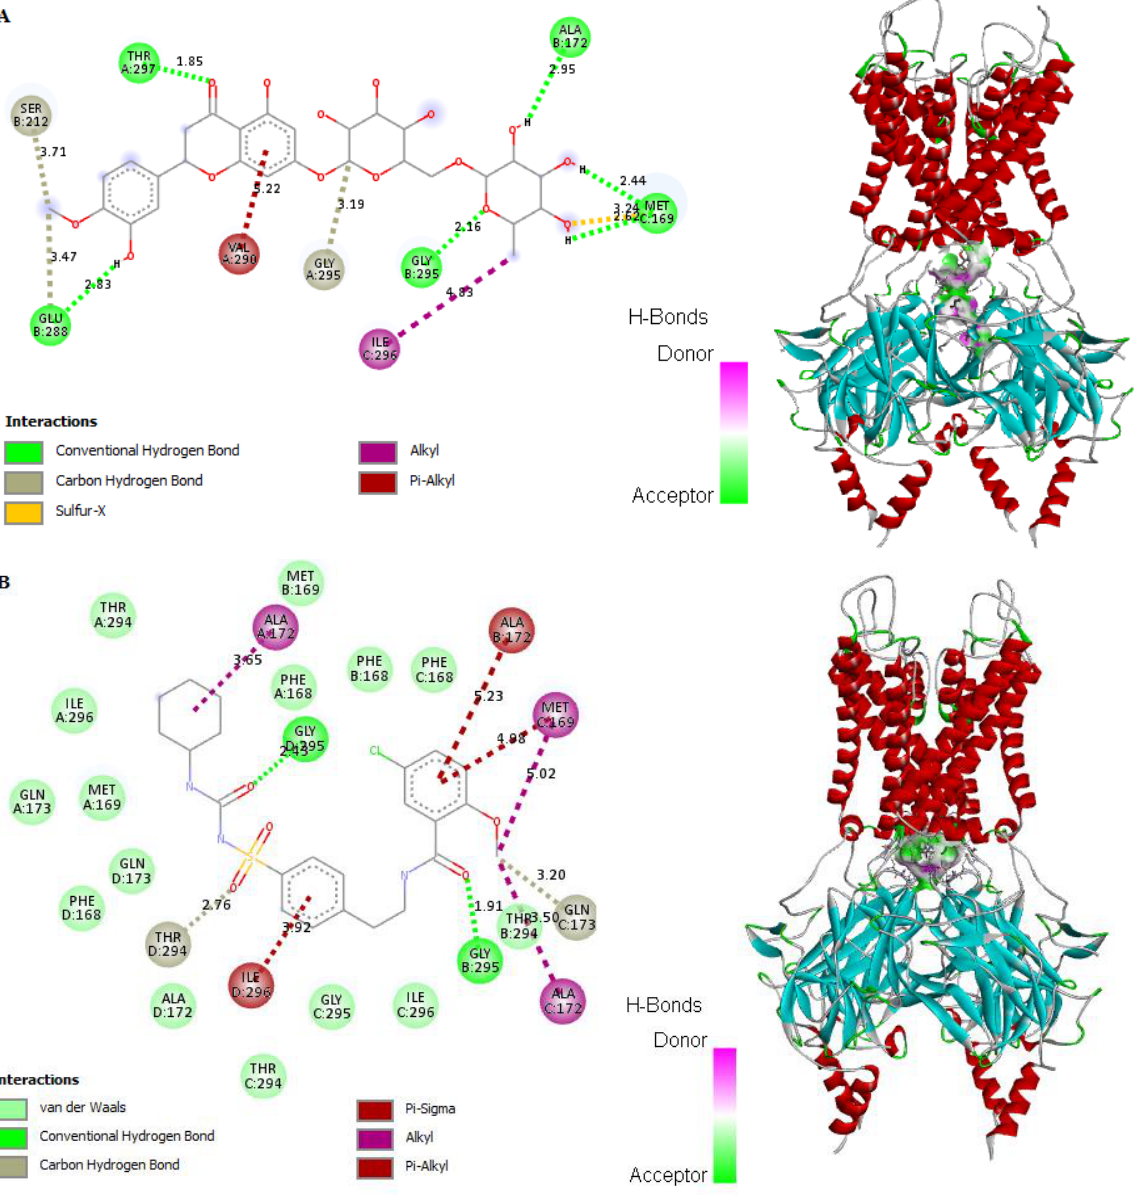
Figure 7. In silico docking and binding interactions of ( A ) HSP and ( B ) GB with ABC transporter SUR1 showing the analysis of amino-acid interactions and their length, together with the binding pocket of ligand–receptor interactions. HSP, hesperidin; GB, glibenclamide. 2.9. In Silico Binding of HSP and GB with NF- κ B, Cleaved caspase-3, BAX, and BCL2 Markers HSP showed improved binding affinity with NF- κ B and cleaved caspase-3 ( − 4.92 and − 8.44 kcal/mol, respectively) in comparison to the standard GB ( − 4.70 and − 6.35 kcal/mol, respectively). The receptor showed stable binding with both ligands (HSP and GB) through the formation of conventional hydrogen bonds, carbon hydrogen bonds, alkyl hydrophobic interactions, and various pi–alkyl interactions. Interestingly, HSP formed five